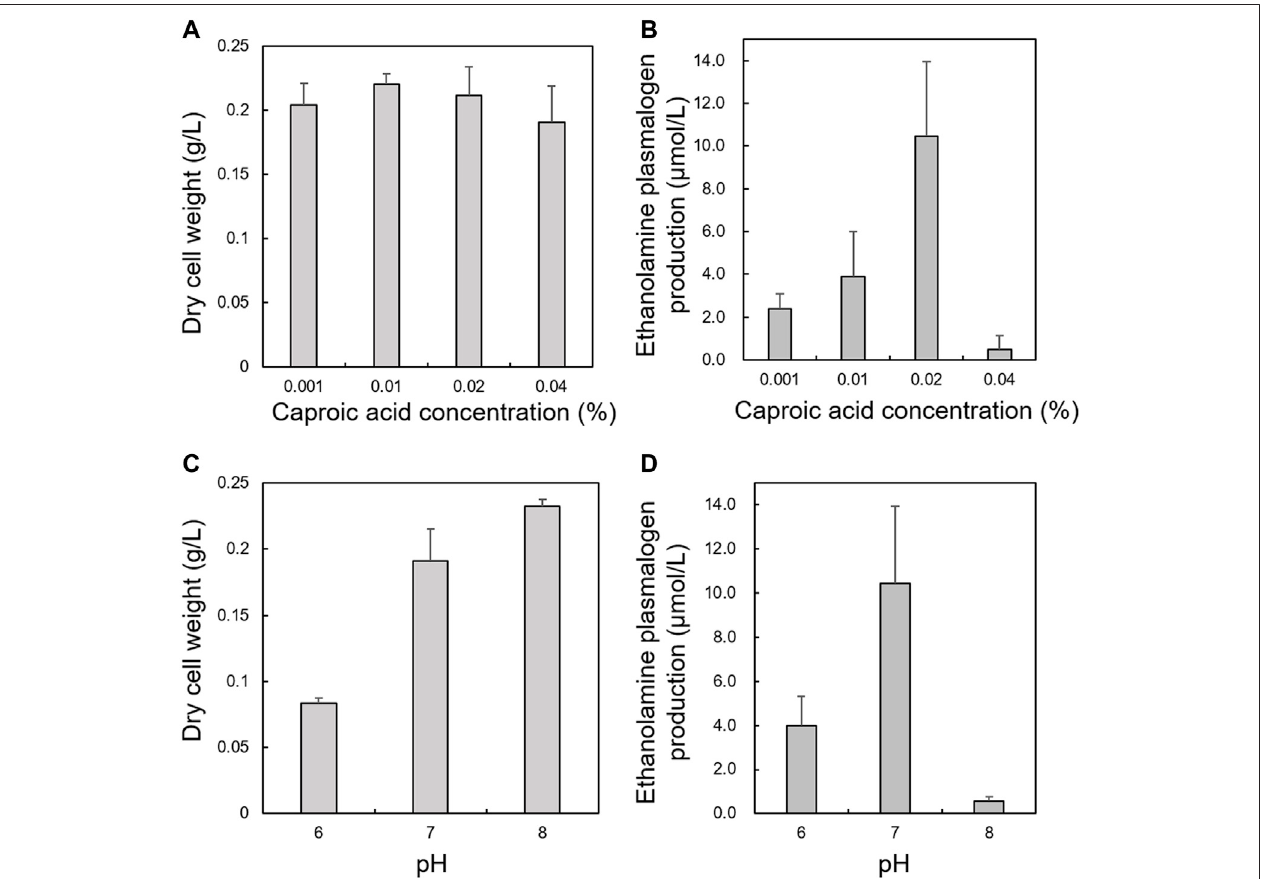
FIGURE 2 | Effects of caproic acid concentration and pH on growth and PlsEtn production in S. ruminantium . Effect of caproic acid at different concentrations on (A) growth of S. ruminantium and (B) PlsEtn production of S. ruminantium in the glucose medium at 37 ° C and pH 7.0 for 24 h. Effect of pH on (C) the growth of S. ruminantium and (D) PlsEtn production of S. ruminantium in the glucose medium containing 0.02% caproic acid at 37 ° C for 24 h. Dry cell weight was measured after freeze drying. PlsEtn production was measured by LC-MS/MS analysis of lipids extracted from dry cells. The data represent mean ± SD ( n = 3).